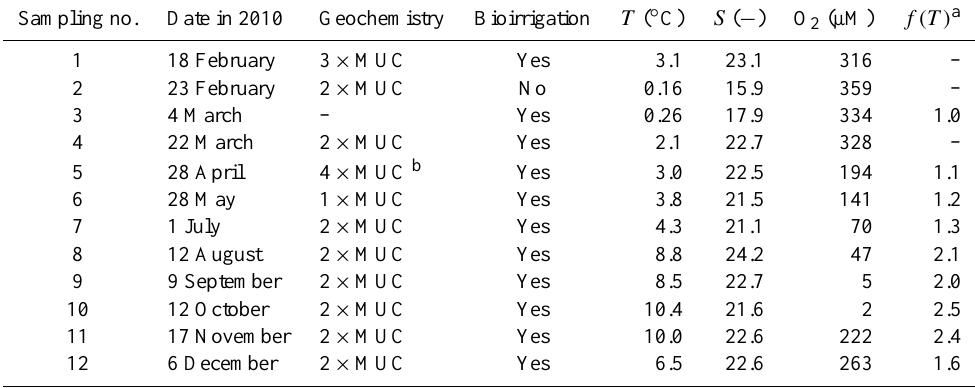
Table 1. Sampling dates where multiple cores (MUC) were retrieved for geochemical analysis and bioirrigation experiments. Temperature, salinity and dissolved oxygen data in the bottom water (28m) are also listed, along with the temperature-correction factor for reaction rates, f (T )